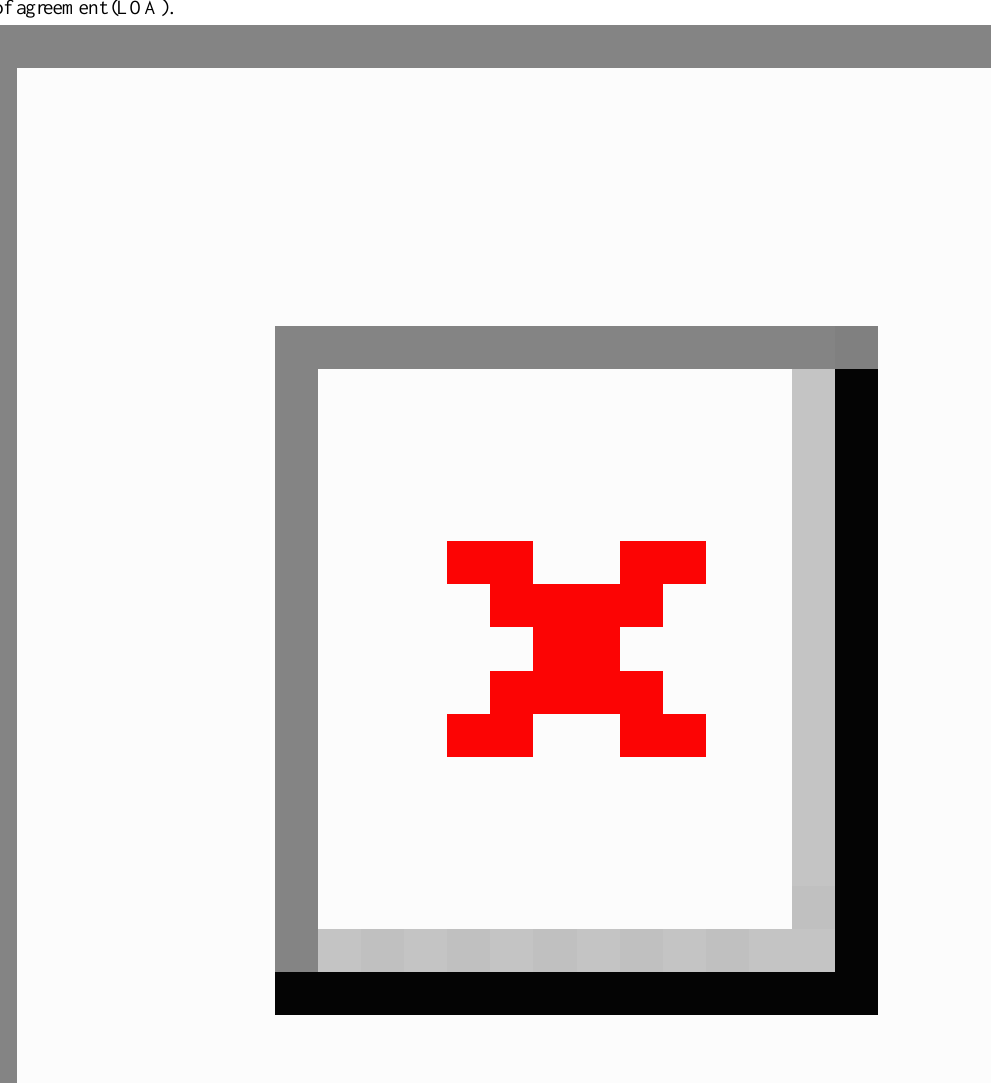
Figure 1. Level of agreement between self-reported and measured height (cm). Solid line represents the mean difference and dotted line represents the limits of agreement